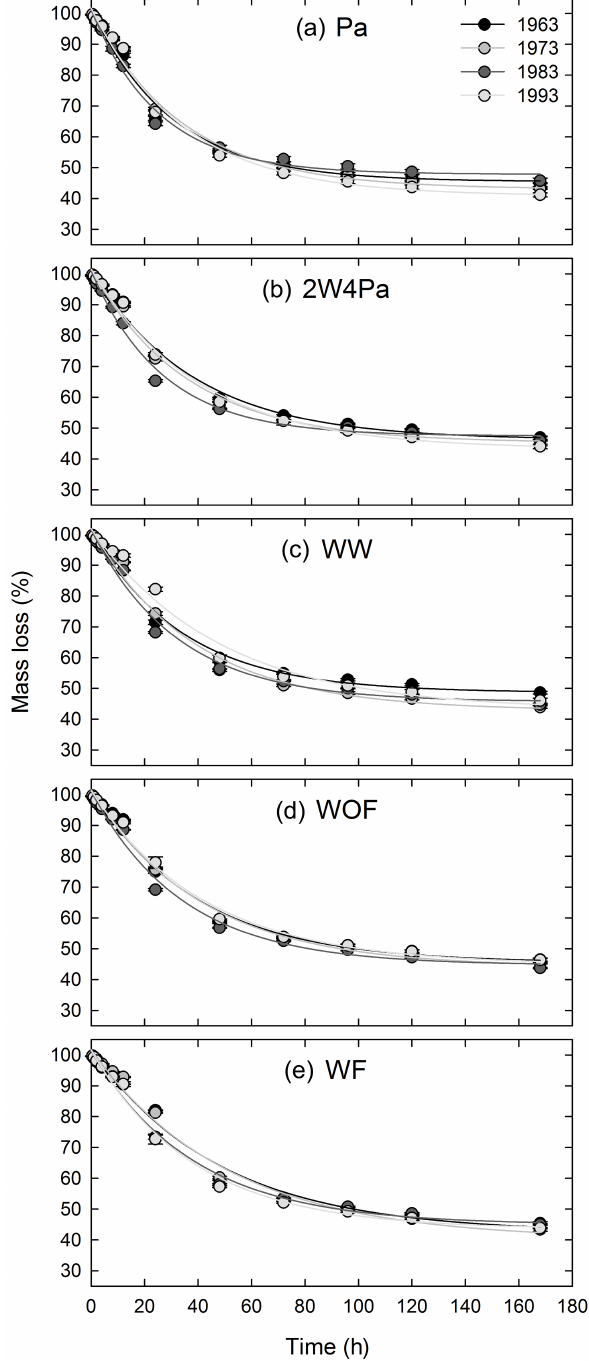
Figure B1. Root exudate incubation results presented as percentage mass loss. Each point represents mean ± 1SEM ( n = 3). Error bars are smaller than symbols. Best-fit single-pool exponential models are also shown (adjusted R 2 >0.98 for all